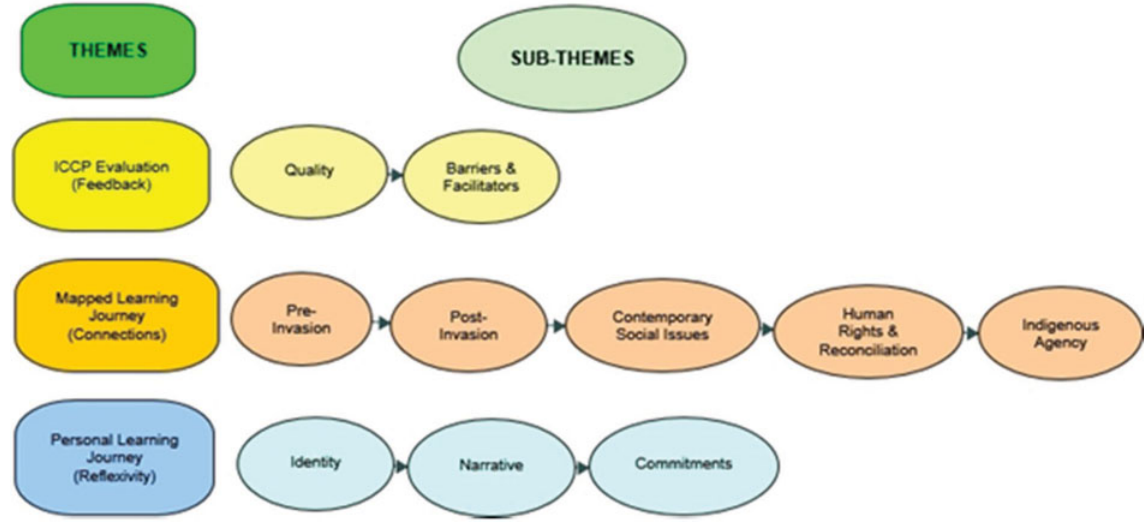
(Colour online) Indigenous cultural competency programme themes and